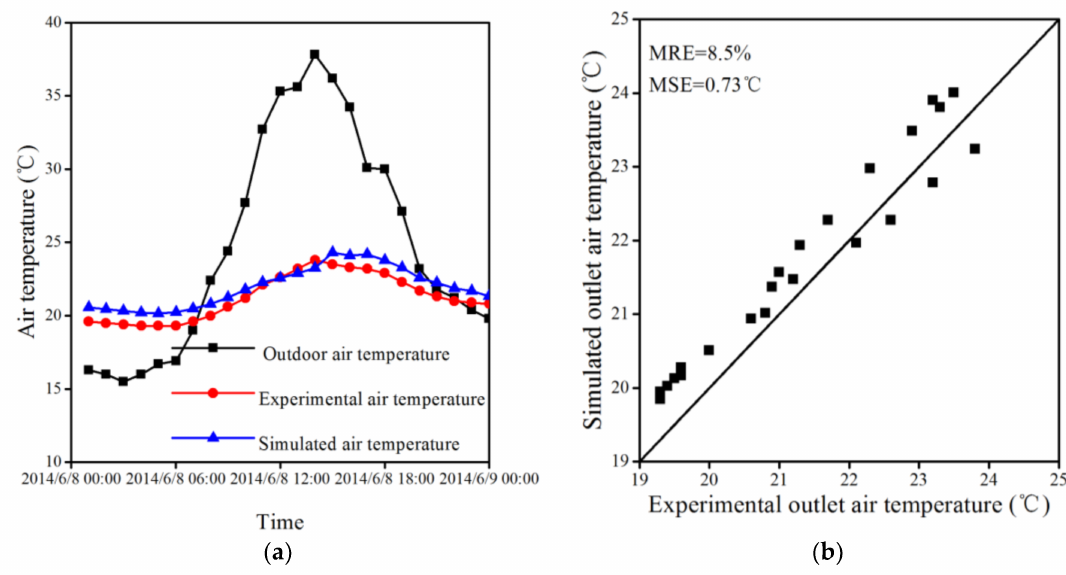
Figure 7. Comparison of the outlet air temperature of EAHE. ( a ) comparison of testing and simulated data ( b ) error analysis of testing and simulated data.